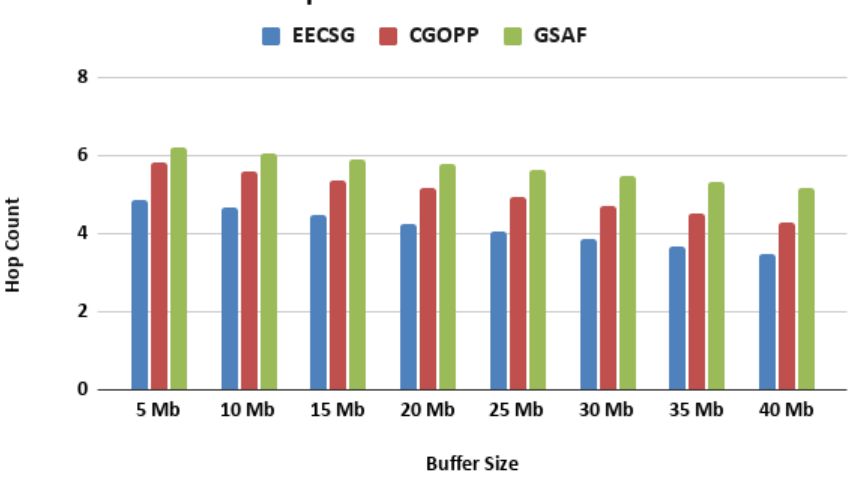
Figure 13. Hop count vs. buffer size using real data mobility